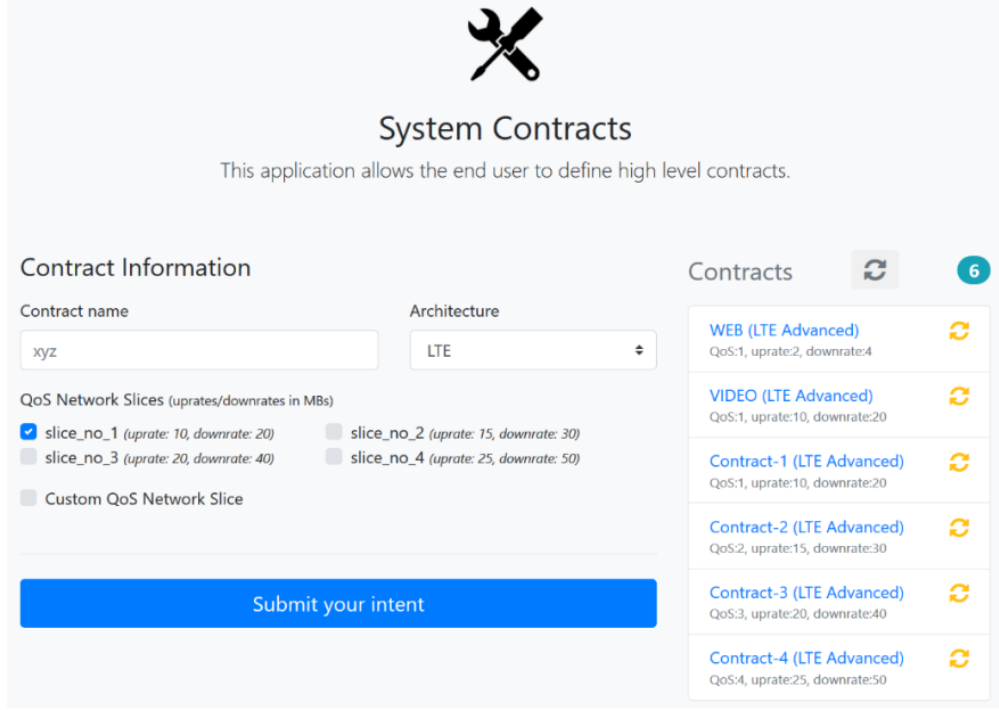
Figure 10. GUI of intent-based networking